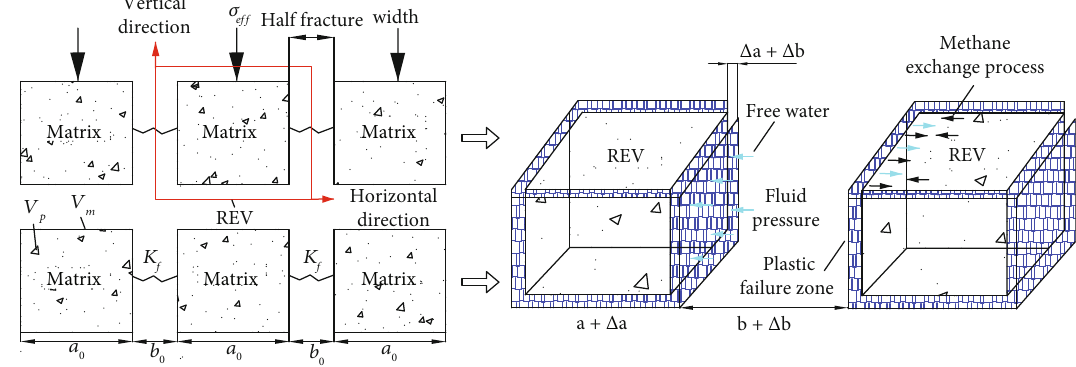
Figure 4: Sketch of a coal matrix with a